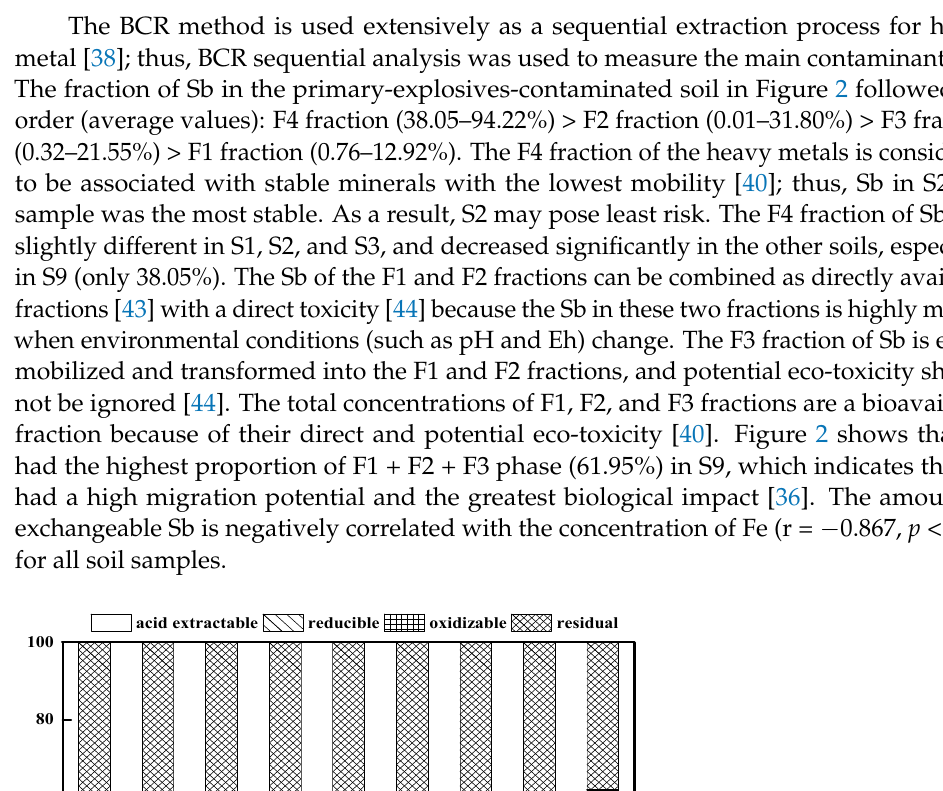
Table 1. Main physicochemical characteristics of soils.